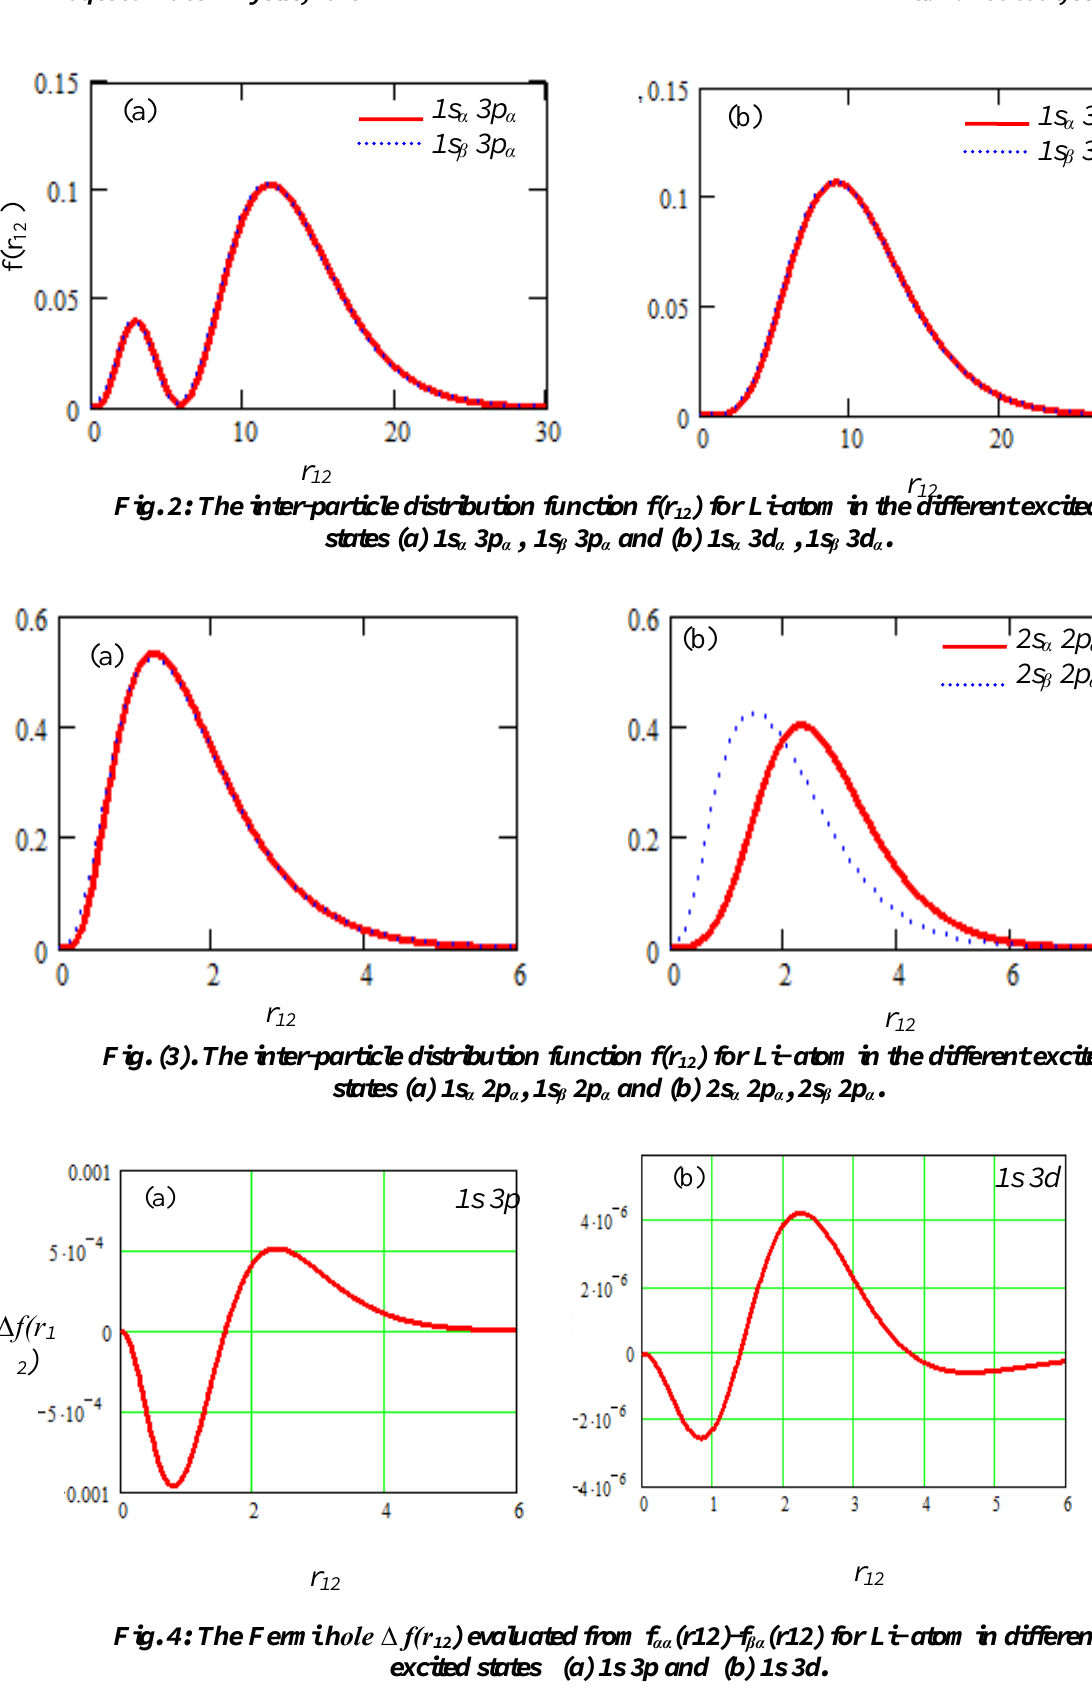
) evaluated from f 12 excited states (a) 1s 3p and (b) 1s